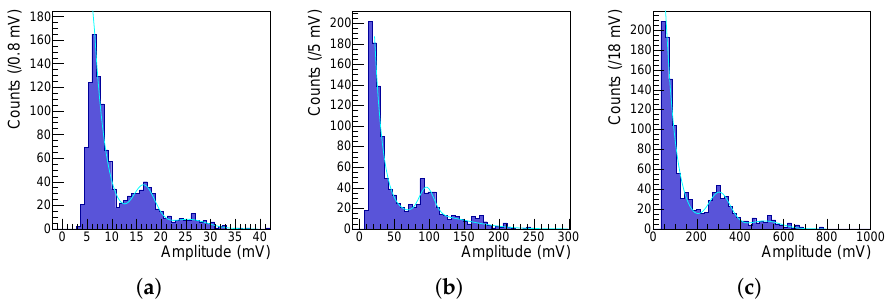
Figure 20. The waveform amplitude spectra for anodes ( a ) 1, ( b ) 2, and ( c ) 3. The counts shown on the vertical axis are normalized to the time of one CCD exposure, i.e., 2s. The spectra are fitted with an exponential plus two Gaussian functions. The amplitude spectra shown are summed data over 15 consecutive runs taken at the same voltage settings, V a 1 = 1200V, V a 2 = 2400V, V a 3 = 3600V, and V c = −